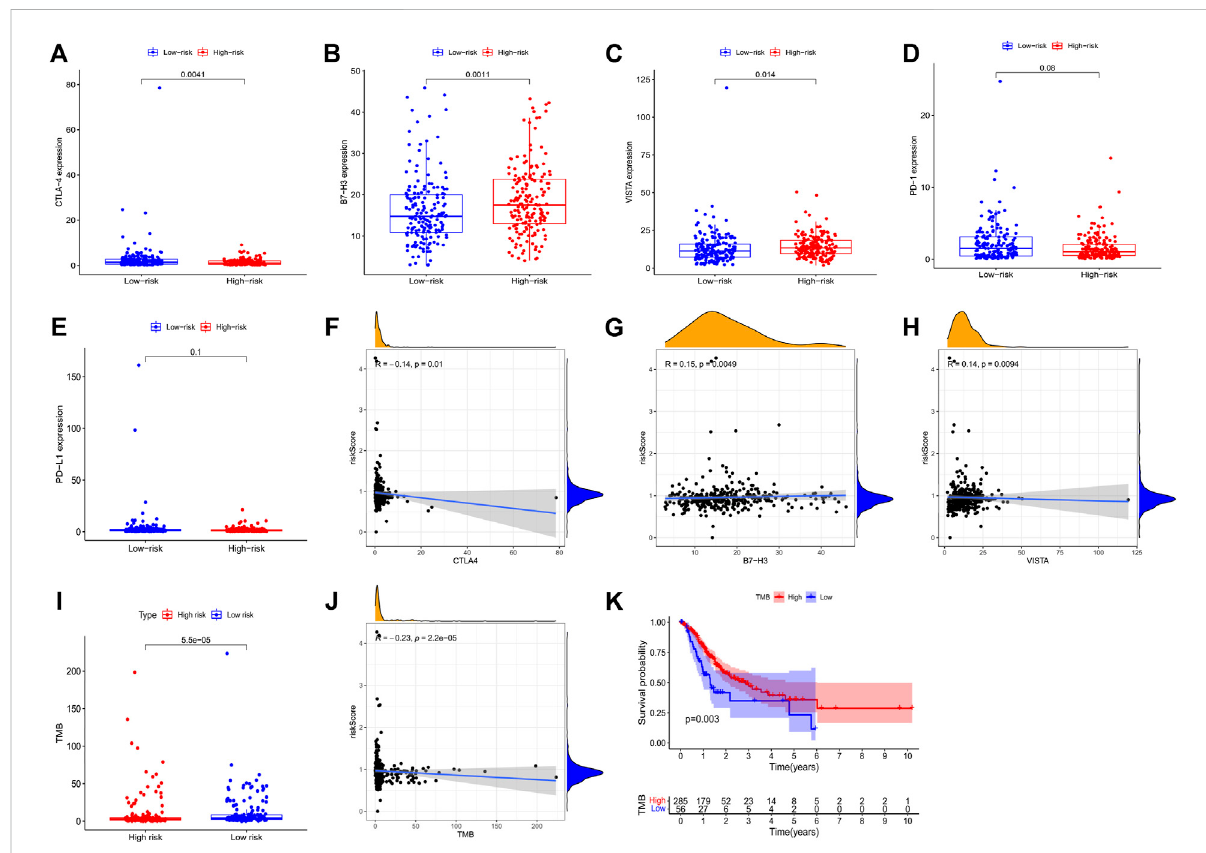
FIGURE 6 Correlation assessment of the immune checkpoint genes with GC patients ’ risk score. (A – E) Exhibited the expression level of immune checkpoint genes in high- and low-GC risk groups. (F – H) Exhibited the correlation between the expression level of immune checkpoint genes and the risk score of GC patients. (I) A boxplot demonstrated the different TMB level in high-GC and low-GC risk groups. (J) The correlation of TMB with risk score. (K) Kaplan-Meier survival analysis of the high-GC and low-GC TMB groups in GC patients. GC, gastric